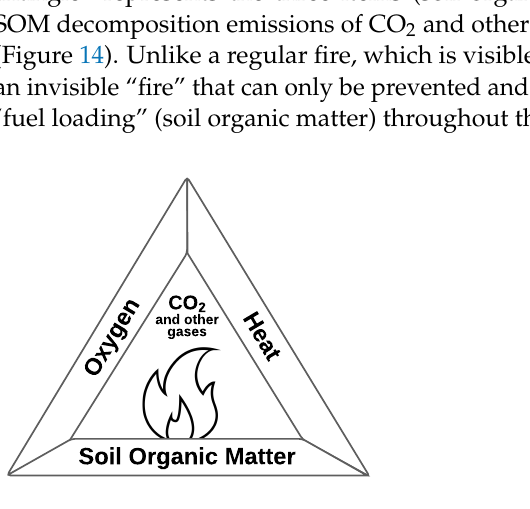
Figure 14. The “SOM decomposition triangle” represents the three items (soil organic matter, oxygen, and heat) that feed soil decomposition emissions of CO 2 and other gases that fuel global